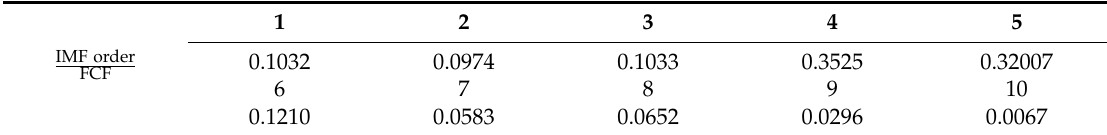
Table 4. Fault correlation factor of each IMF.